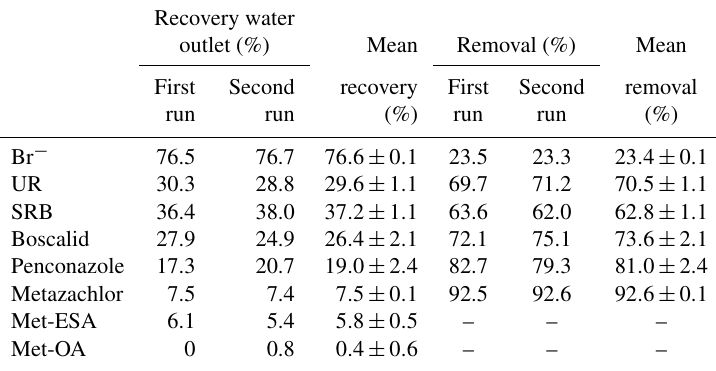
Mean recovery and mean removal represent means ± standard